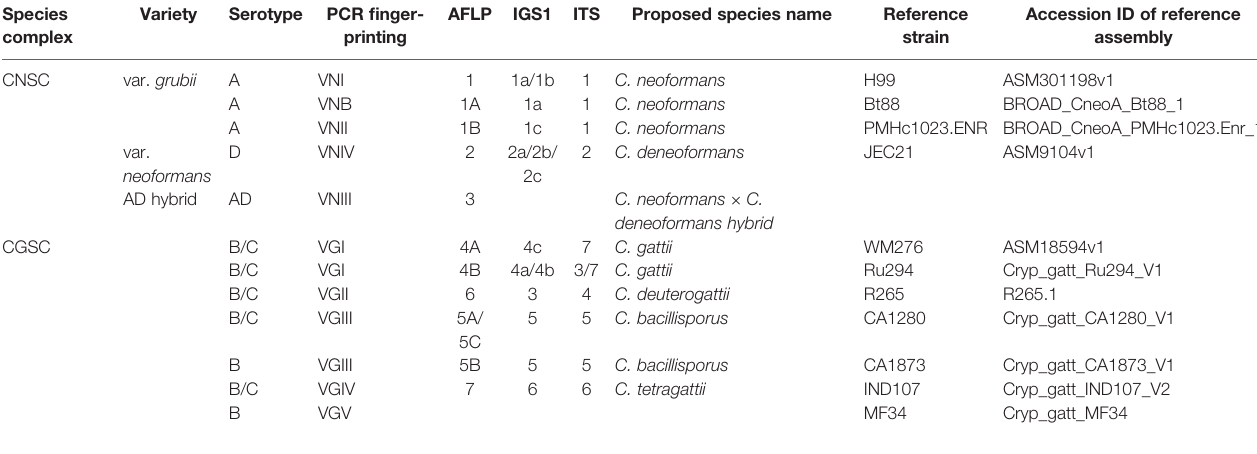
TABLE 2 | Summarized classi fi cation of CNSC and CGSC based on different molecular markers. Species